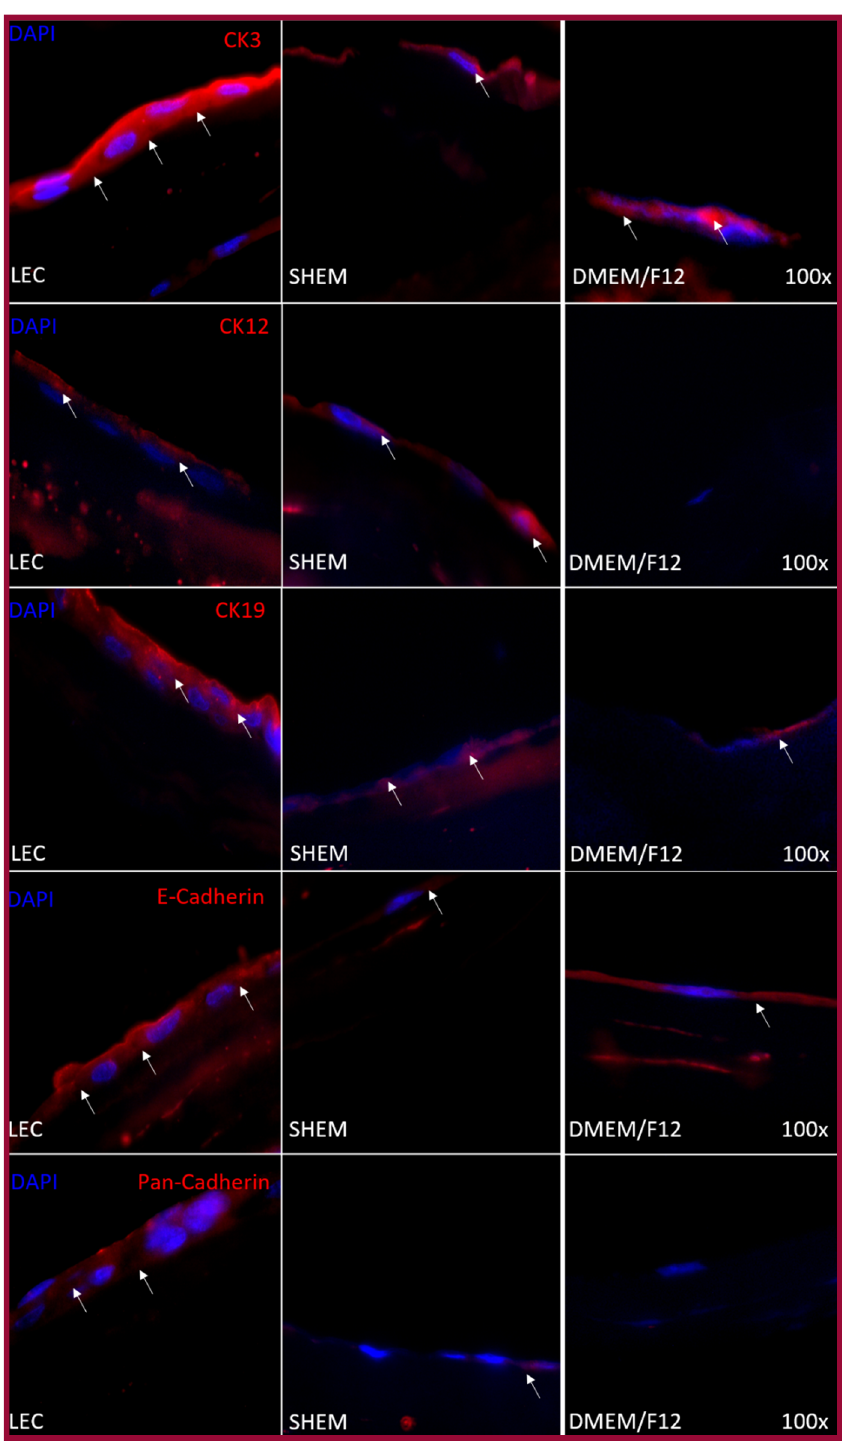
Figure 7. Epithelial marker expression with AM. Cytokeratin-3 was highly expressed in both groups when compared to the positive control (LEC). Cytokeratin-12 was completely absent in the DMEM/F12 group, and although the SHEM group expressed the marker, its expression was lower than with LEC. Cytokeratin-19 was expressed in all groups, but when compared to LEC, the expression in the DMEM/F12 group was lower than in the SHEM group. Pan-Cadherin was absent from the DMEM/F12 group and even though the SHEM group expressed the marker it was very modest in scattered cells. E-cadherin was expressed by all groups, but it was scattered in the cytoplasm of the cells in the DMEM/F12. The SHEM group positivity was mainly localized in the periphery of the nucleus.